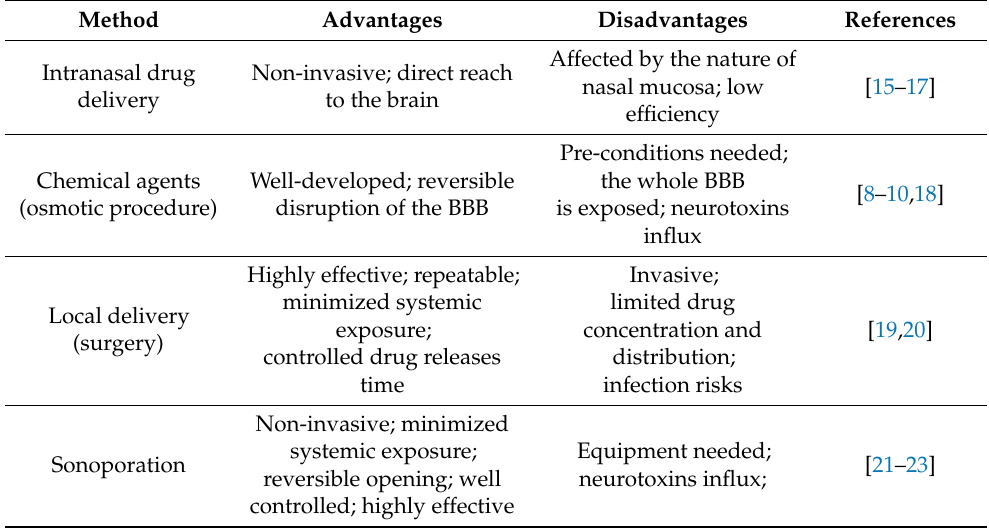
Table 1. Different methods of drug delivery to the